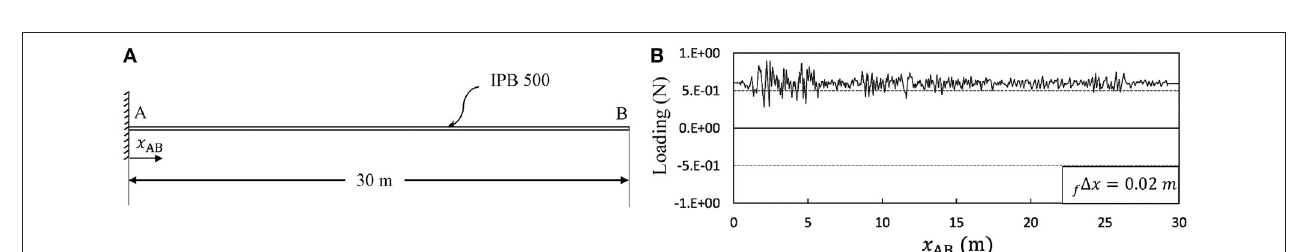
FIGURE 2 | Structural system under consideration in the first example (A) structural model and (B) digitized static loading.